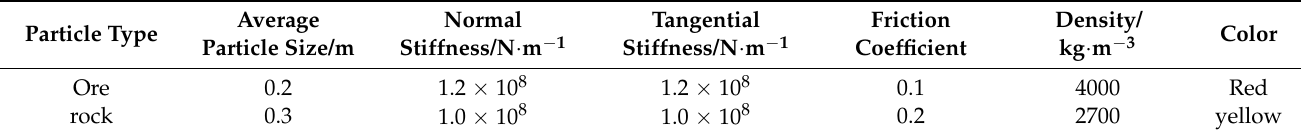
Table 1. Micromechanical parameters of the model.